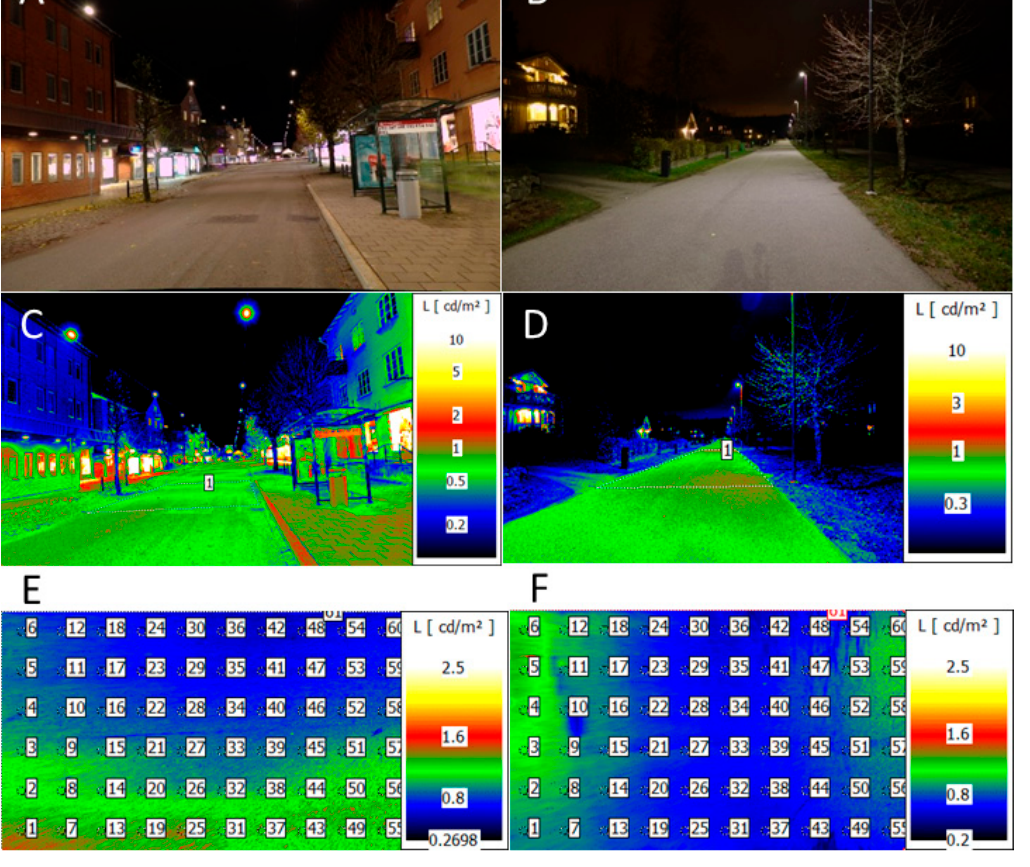
Figure 2. Photos and luminance photos and evaluations of ( left ) Fredsgatan ( A , C , E ) and ( right ) Vreta Gårds väg ( B , D , F ). Luminance photos and evaluations have false colours. The luminance scale is individual and is therefore shown in each photo and evaluation. Photos were taken with a Canon EOS 550D (zoom 17–50 mm, F2.8; F4, ISO100) set 150 cm above the ground on a tripod.